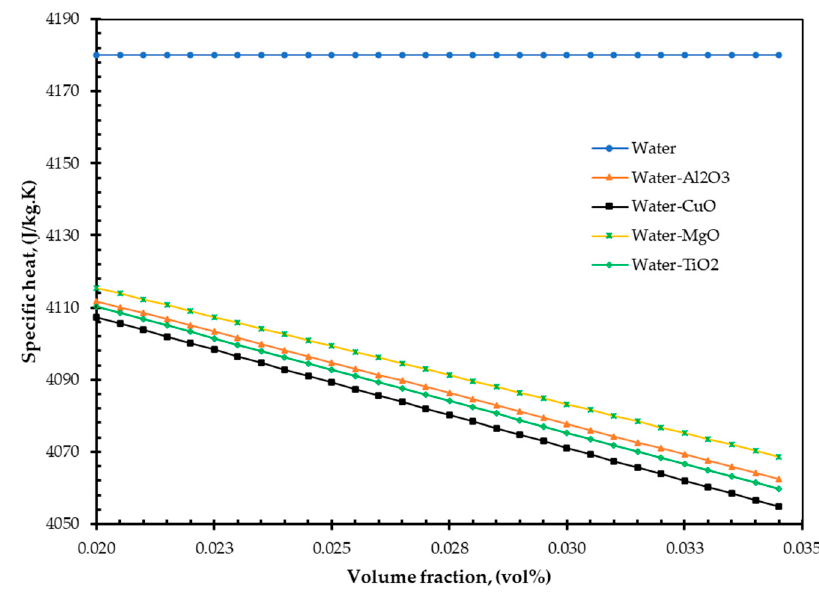
Figure 4. Effect of volume fraction on specific heat.